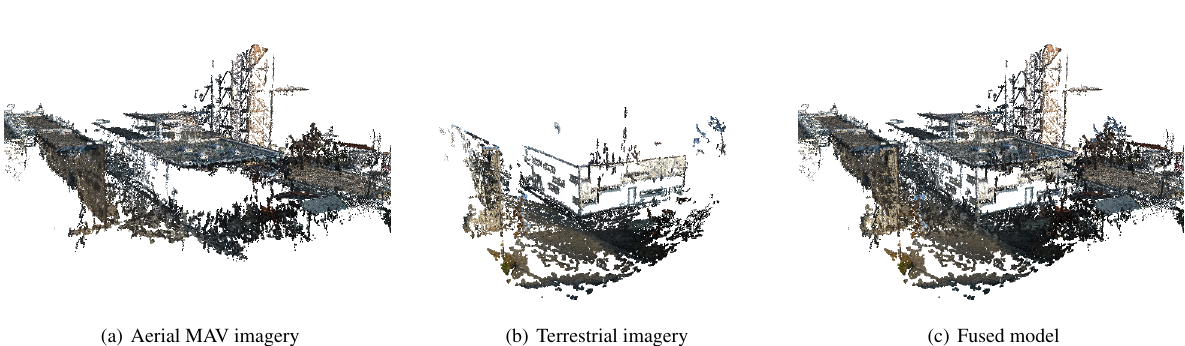
Figure 4: Fusion of two models computed from airborne and ground–level images. (a) Reconstruction obtained by nadir images at 60m height. (b) Model obtained from ground images. (c) Both models fused by our approach.